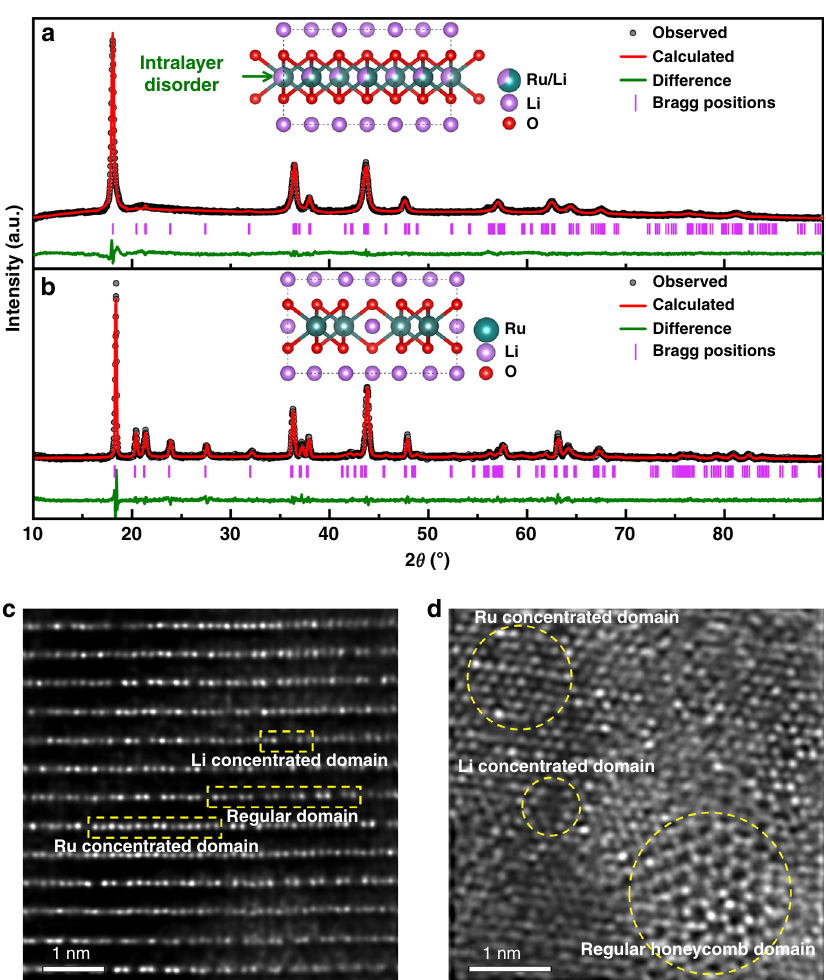
Fig. 3 Structural characterization. a , b XRD patterns of ID-Li 2 RuO 3 ( a ) and R-Li 2 RuO 3 ( b ). The insets show the corresponding crystal models after re fi nement. c , d HAADF-STEM images of the ID-Li 2 RuO 3 sample along the [100] ( c ) and [001] ( d ) zone